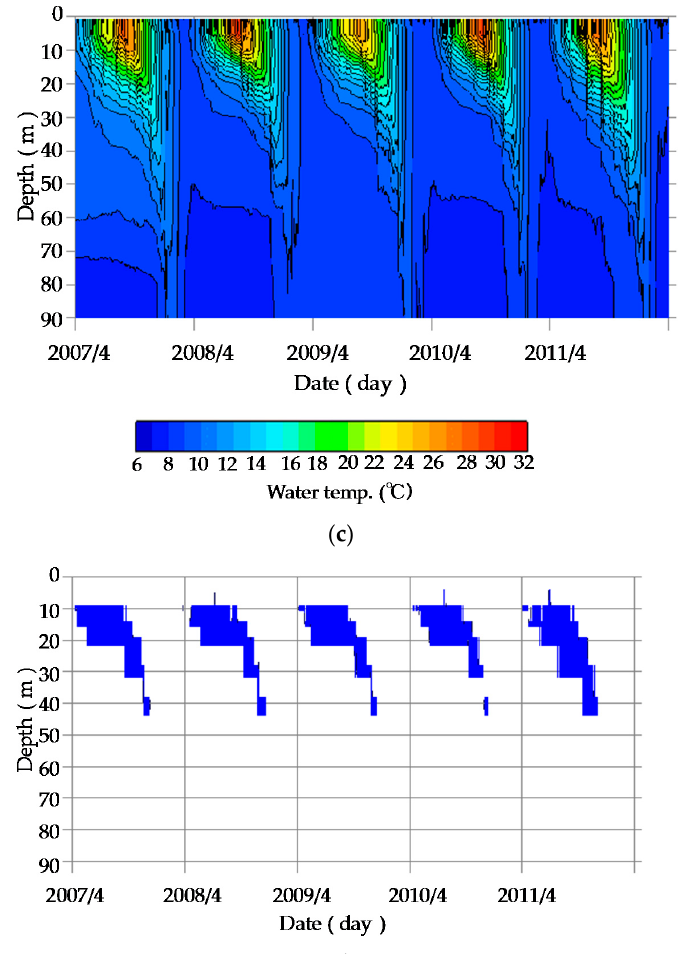
Figure 7. Inter-annual change of ( a ) the vertical water distribution and ( b ) the thickness of the thermocline at the monitoring point in Imazu-oki in the observation; and ( c ) the vertical water distribution and ( d ) the thickness of the thermocline at the same point in the simulation.